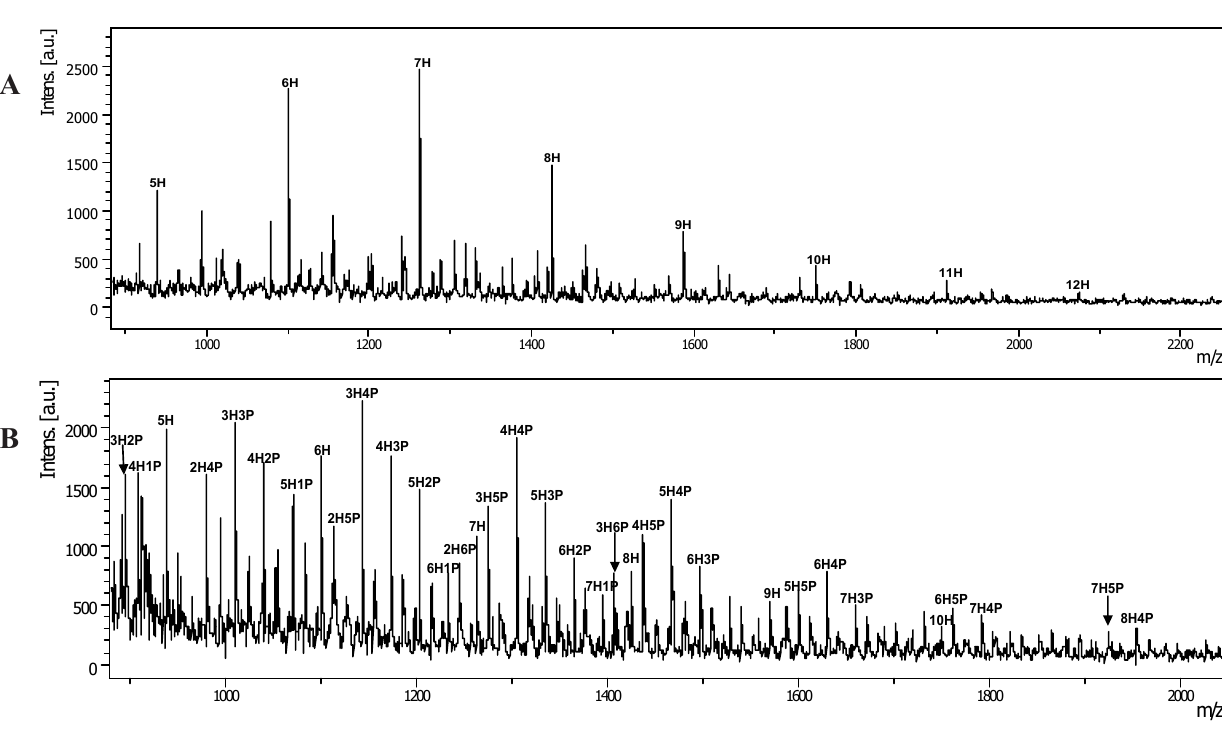
Figure 3. ( A ) MALDI-TOF MS of glucomannan-BIM derivatives. The mass difference of 162.1 Da was observed; ( B ) MALDI-TOF MS of arabinogalactan-BIM derivatives. The sample load is set at 2 µL of 1,000 ppm polysaccharide solution in each dot on the steel plate and the conditions of MALDI-TOF MS are the same as that described in Figure